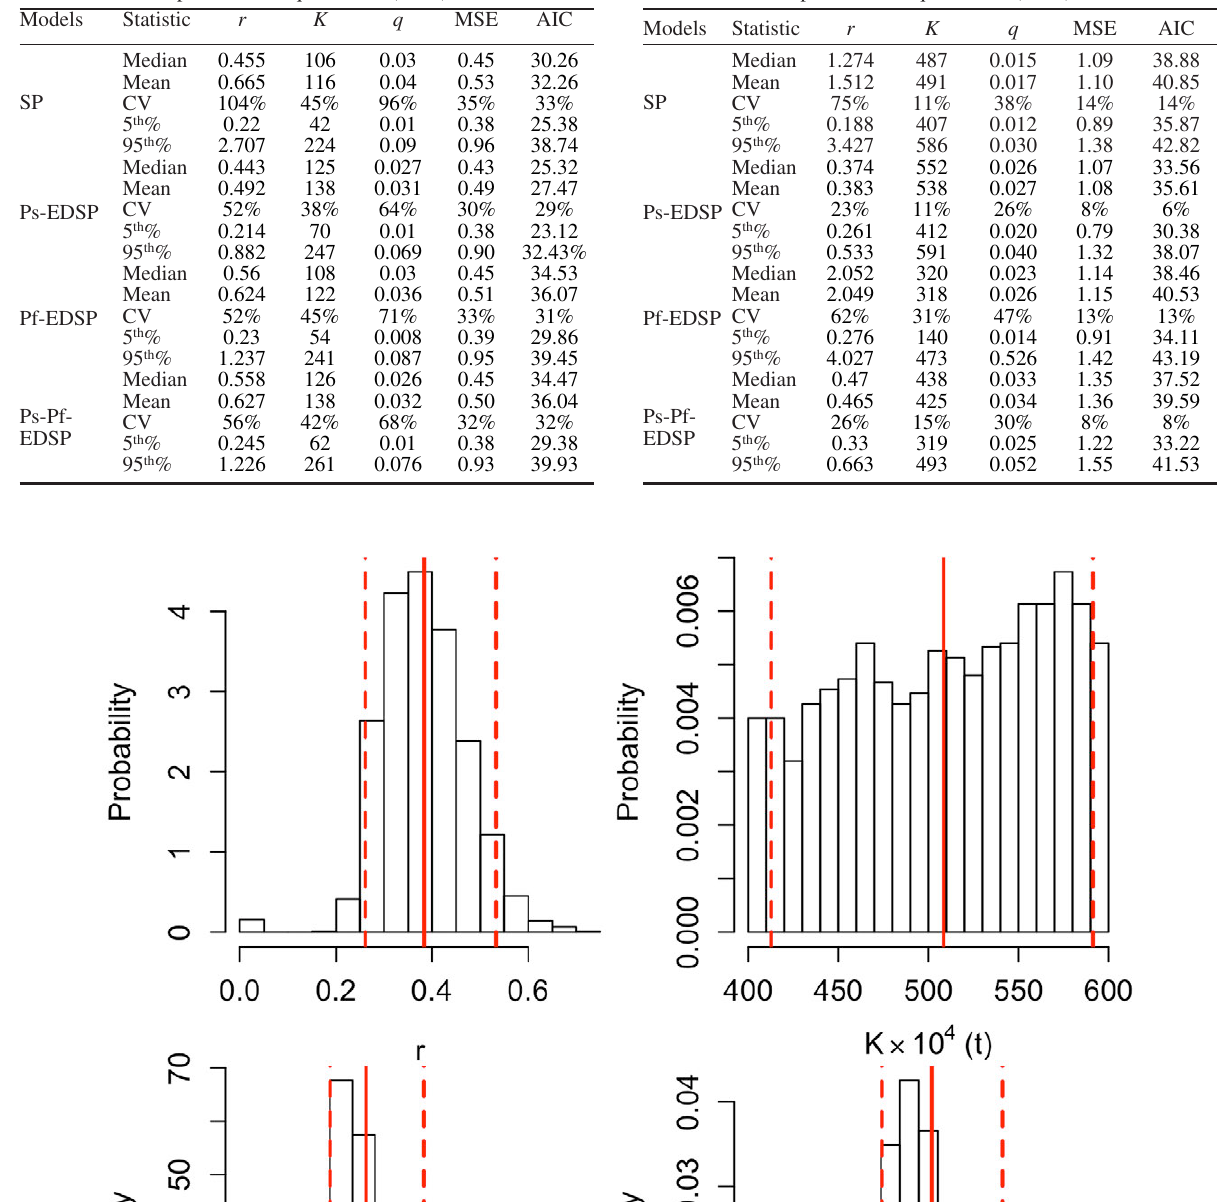
Table 5. – Summary of the estimates of parameters with the boot- strapped ML method from 1500 runs of bootstrap simulation for CPUE and catch data observed from 2000 to 2010 for I. argentinus. For each bootstrap run, mean square error (MSE) was